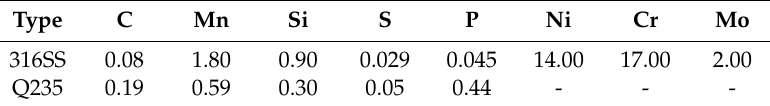
Table 1. The element content of 316 SS and